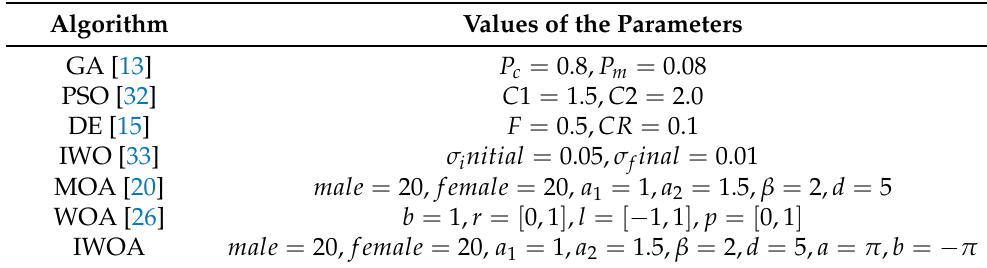
Table 2. Parameter setups of different